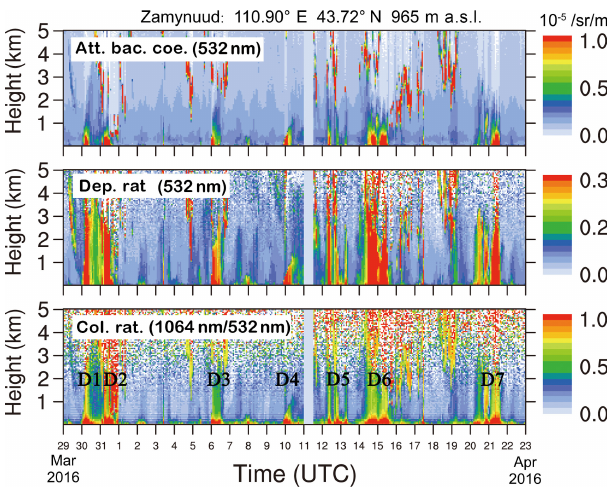
Figure 2. Lidar observations in Zamynuud during the sampling pe- riod. D1–D7 represent dust events that occurred in